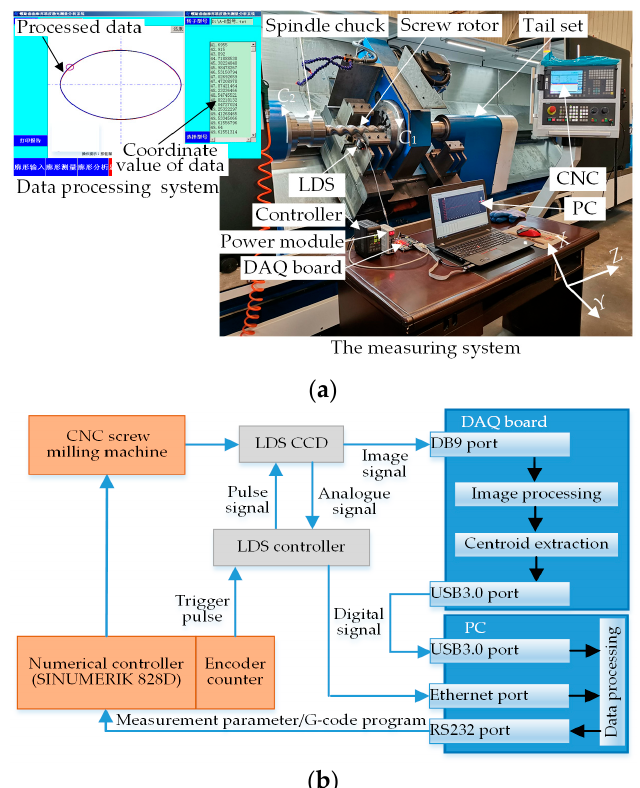
Figure 10. LDS-based on-machine measuring system of double-headed screw rotor. ( a ) Set-up diagram of on-machine measuring system; ( b ) signal flowchart of on-machine measuring system.